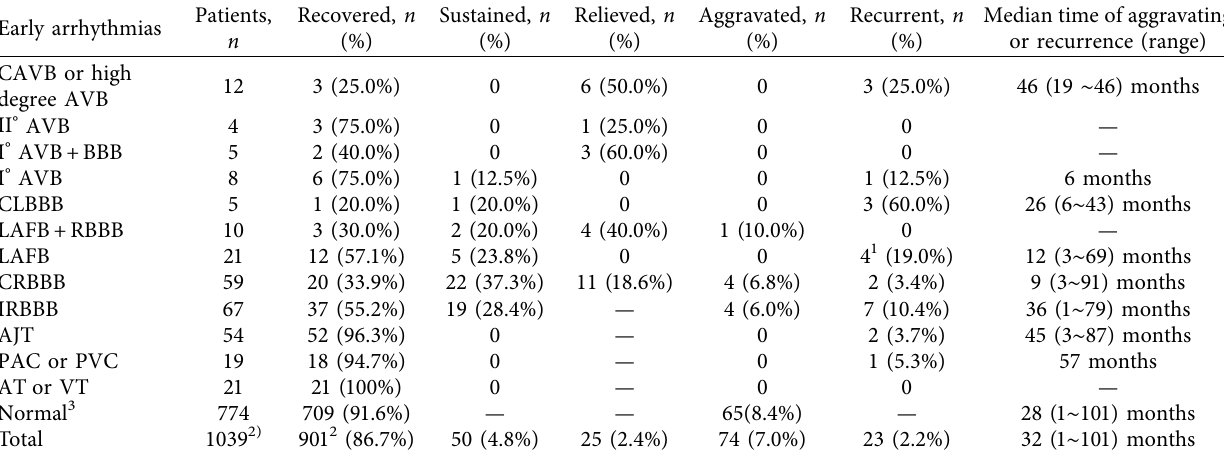
Table 3: The long-term change of different types of early